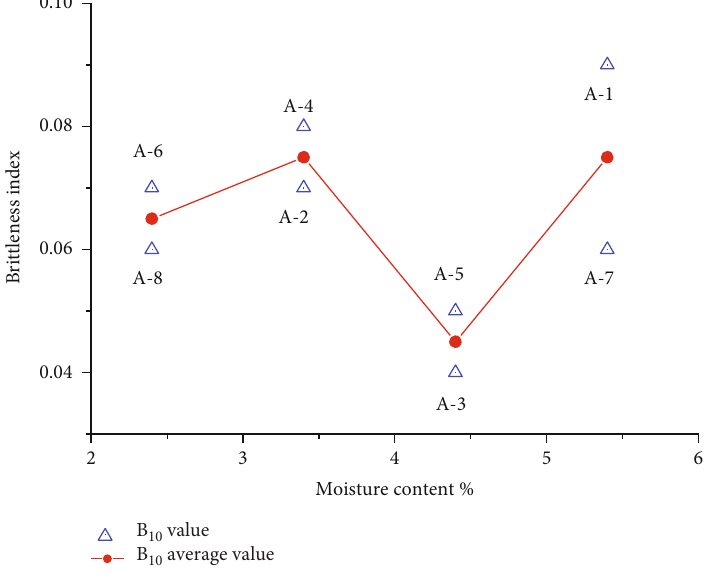
Figure 8: B under di ff erent water content. 10